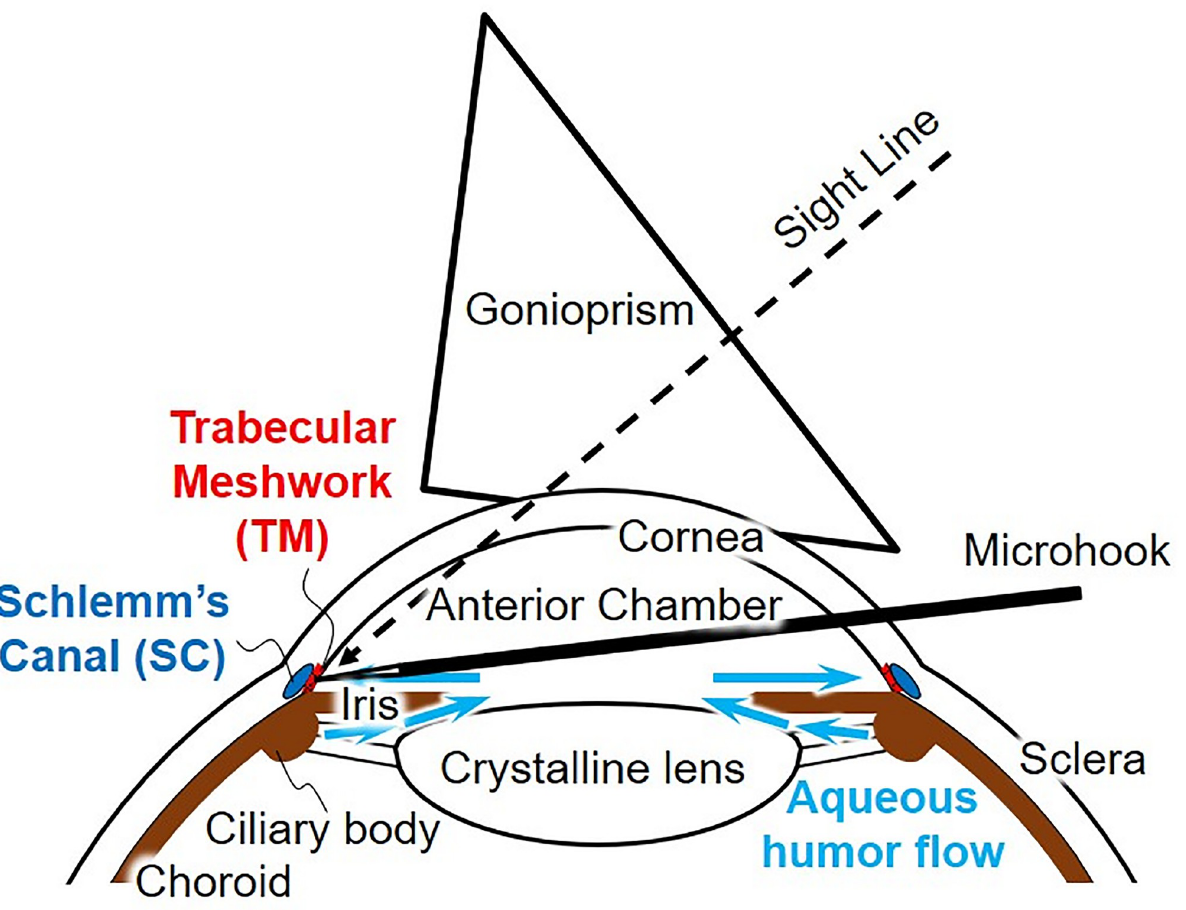
Fig 1. Anterior eye and minimally invasive glaucoma surgery (MIGS)